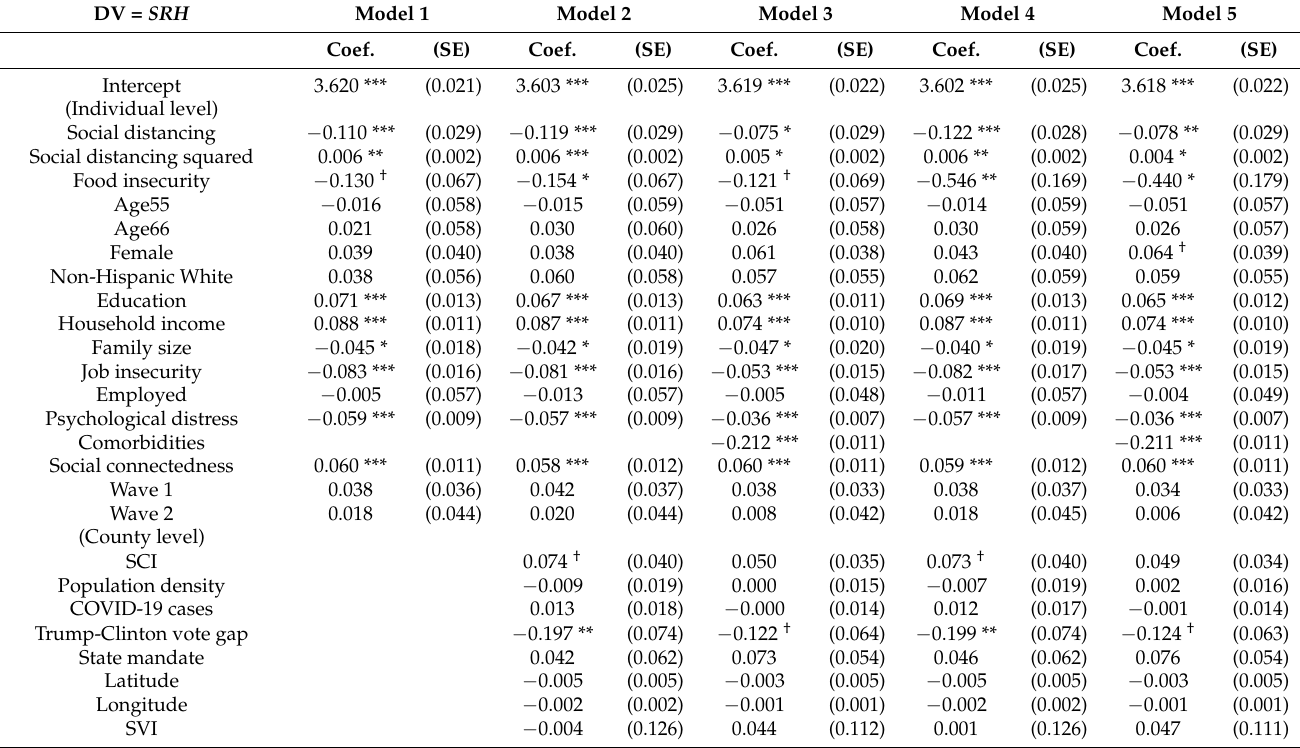
Table 2. Multilevel Analysis Examining the Non-Linear Relationship between Social Distancing Compliance and Self-Rated